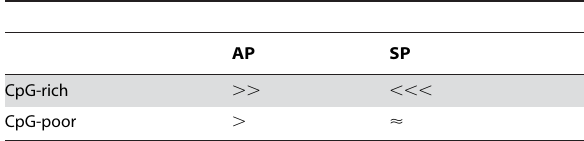
Table 6. The promoter usage in the quiescence SCs compared with the proliferating